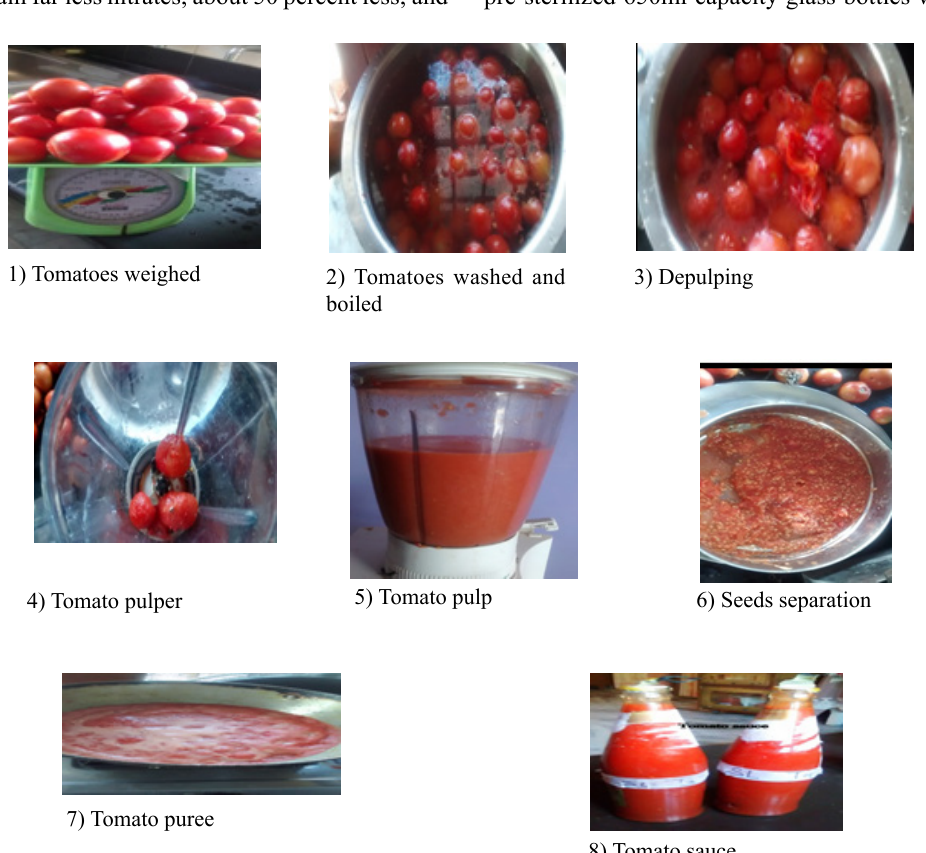
Fig. 1. Pictorial flow sheet for the method followed for the preparation of Tomato sauce from tomato